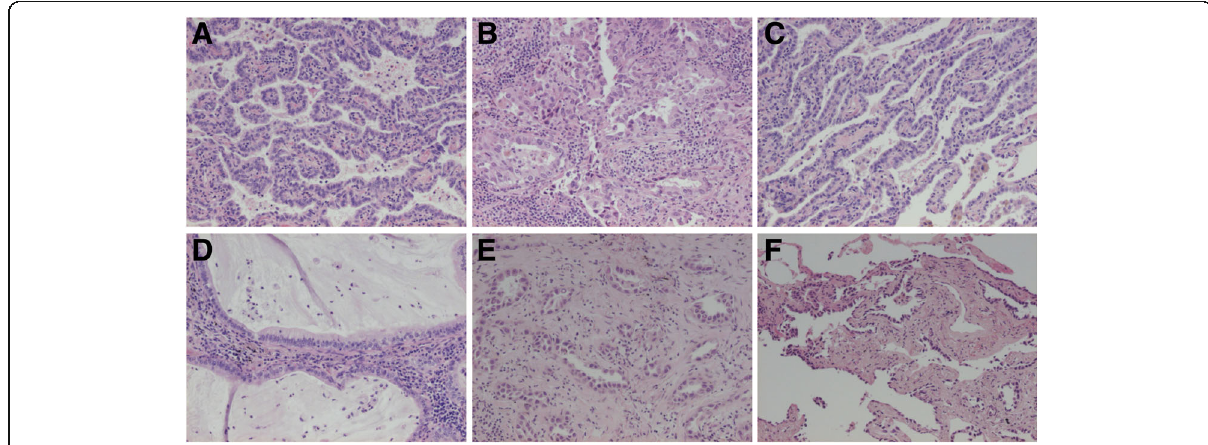
Fig. 3 Case 3. Lung adenocarcinoma with intrapulmonary metastasis with partly different growth patterns but identical genetic profiles. a - d The tumour of the lower lobe with papillary (predominant), acinary, lepidic and mucinous (about 5%) growth patterns. e - f The tumour of the lower lobe with acinary (predominant) and lepidic growth patterns. All images HE and x10